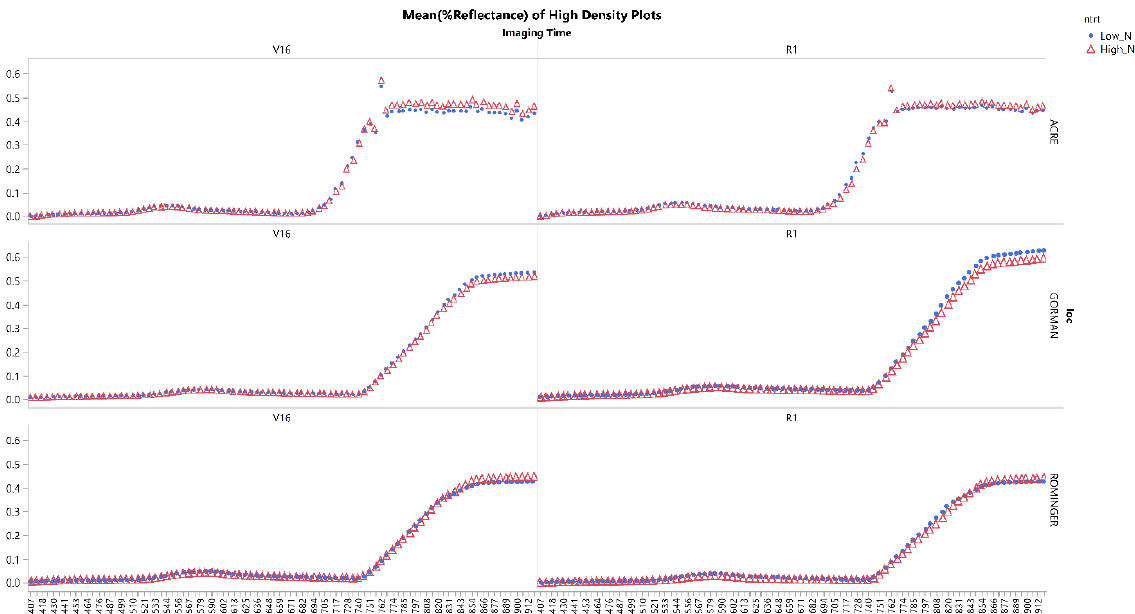
Figure 1. Average spectral signatures (% reflectance) at wavebands from 412–917 nm by location (ACRE, Gorman, Rominger) for high (red triangle) and low N (blue dot) treatment from imaging at V16/V18 or R1/R2 at high planting densities across all